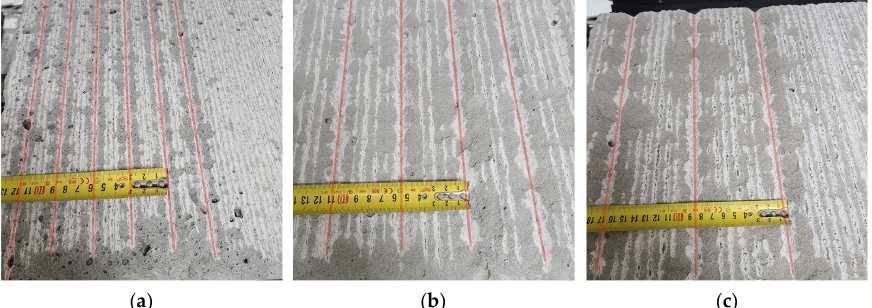
Figure 5. Cutting spacing by penetration depth: ( a ) depth: 3 mm, spacing: 30 mm, ( b ) depth: 6 mm, spacing: 55 mm, and ( c ) depth: 9 mm, spacing: 85 mm.